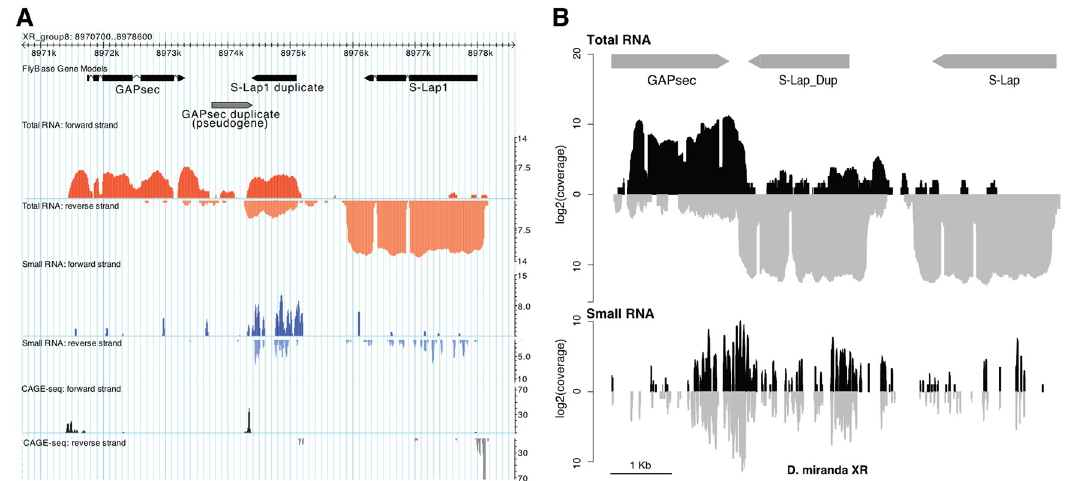
Fig 4. Antisense transcripts and small RNAs are produced from the S-Lap1 and GAPsec gene families. A . Expression and small RNA profiles from wildtype D . pseudoobscura testis. Stranded RNA-seq (red tracks) reveals that the X-linked copy of S-Lap1 - duplicate produces both sense and anti-sense transcripts, resulting in the production of small RNAs (blue tracks). CAGE-seq data (grey tracks) support that the GAPsec duplicate generated a new TSS resulting in antisense transcript of S-Lap1 -dup. B . Expression and small RNA profiles from wildtype D . miranda testis. The D . miranda copies of both GAPsec and S-Lap1 -dup produce both sense and antisense transcripts as well as small RNAs. The antisense transcripts appear to be generated from transcriptional read-through of both genes. Gene expression data are given in S5